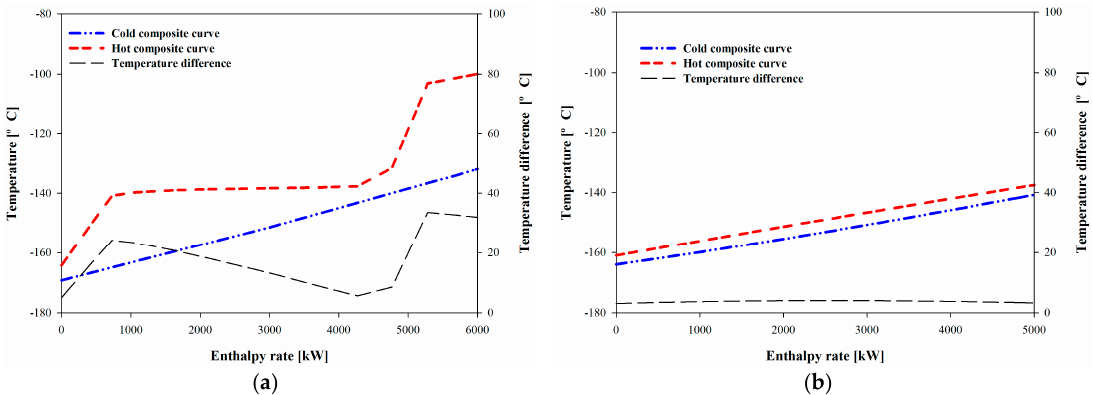
Figure 7. ( a ) Composite curve of HX-102 in System I; and ( b ) composite curve of HX-202 in System II.